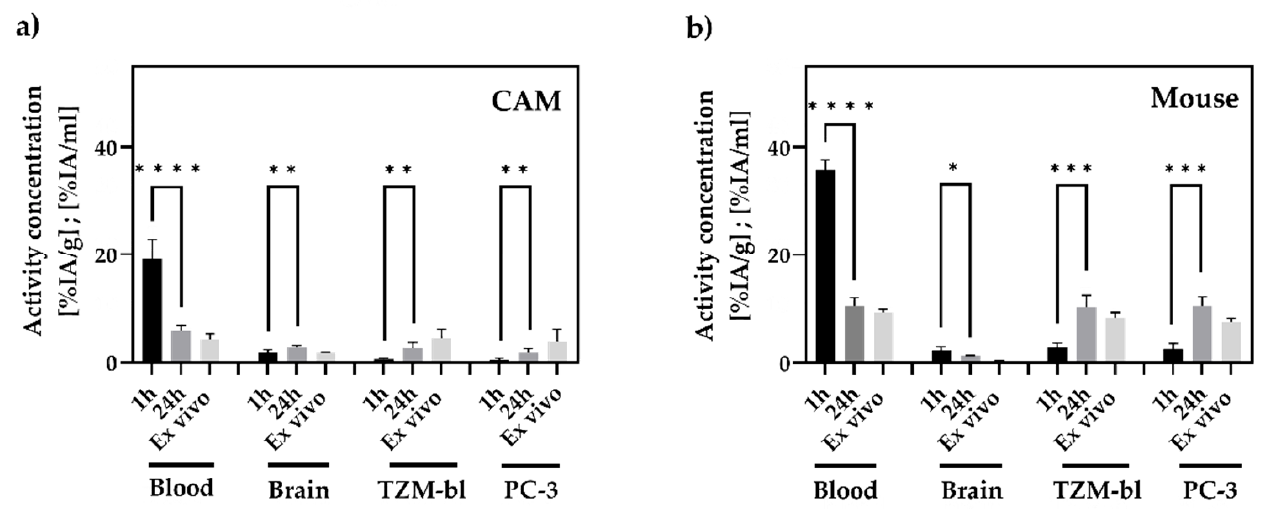
Figure 6. Ex vivo and in vivo biodistribution analysis (%IA/g; %IA/mL) of blood, brain, and tumors after 1 and 24 h p.i. A significantly higher amount of zirconium-89 activity in both tumor entities of both model systems after 24 h p.i. was demonstrated using PET. Significantly less activity was measured in the blood samples of both models after 24 h. While the activity concentration in the brain increased in the CAM model ( a ) after 24 h, there was a decreased observed for the mouse model ( b ). No statistically significant differences were detected between all measured in vivo activity concentrations and the corresponding ex vivo activity concentrations after 24 h. Significance was highlighted by asterisks (* = p ≤ 0.05; ** = p ≤ 0.01; *** = p ≤ 0.005; **** p ≤ 0.0001 (GraphPad Prism, unpaired t -test).